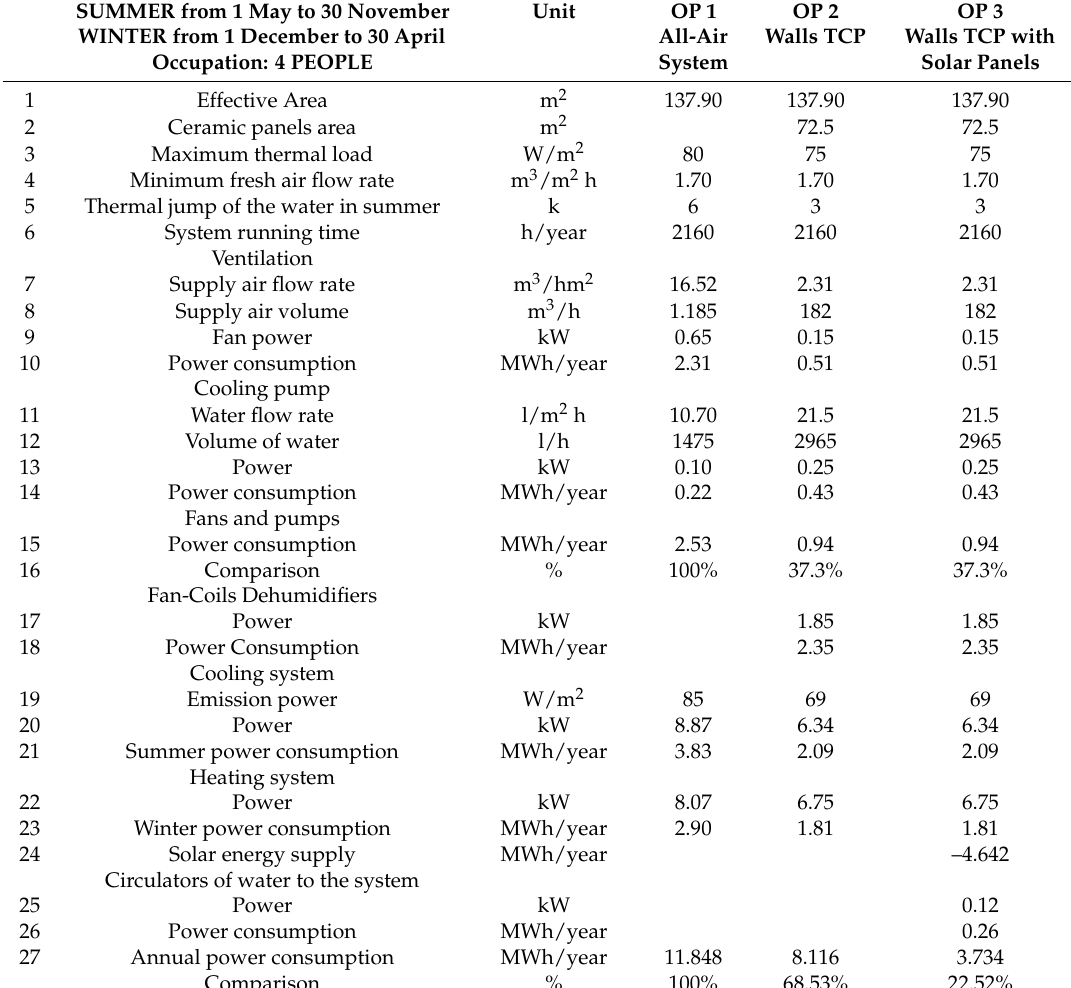
Table 10. The calculation of the annual energy consumption and comparison with convective